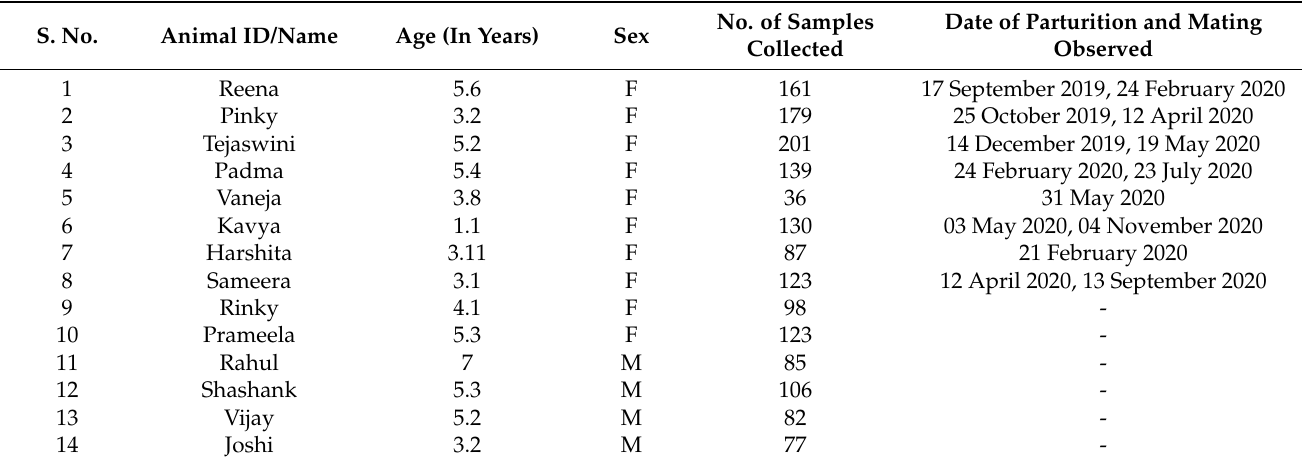
Table 1. Details of animal ID, age, sex, number of fecal pellets collected and date of parturition, mating, and postpartum